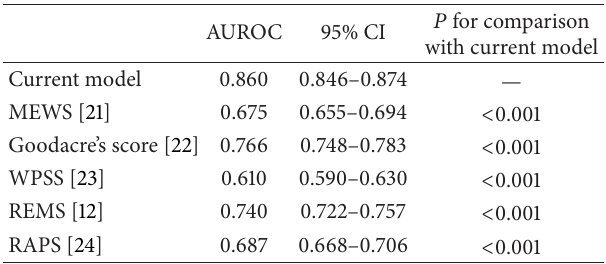
Table 5: Comparison of current logistic model with existing scores for the prediction of hospital